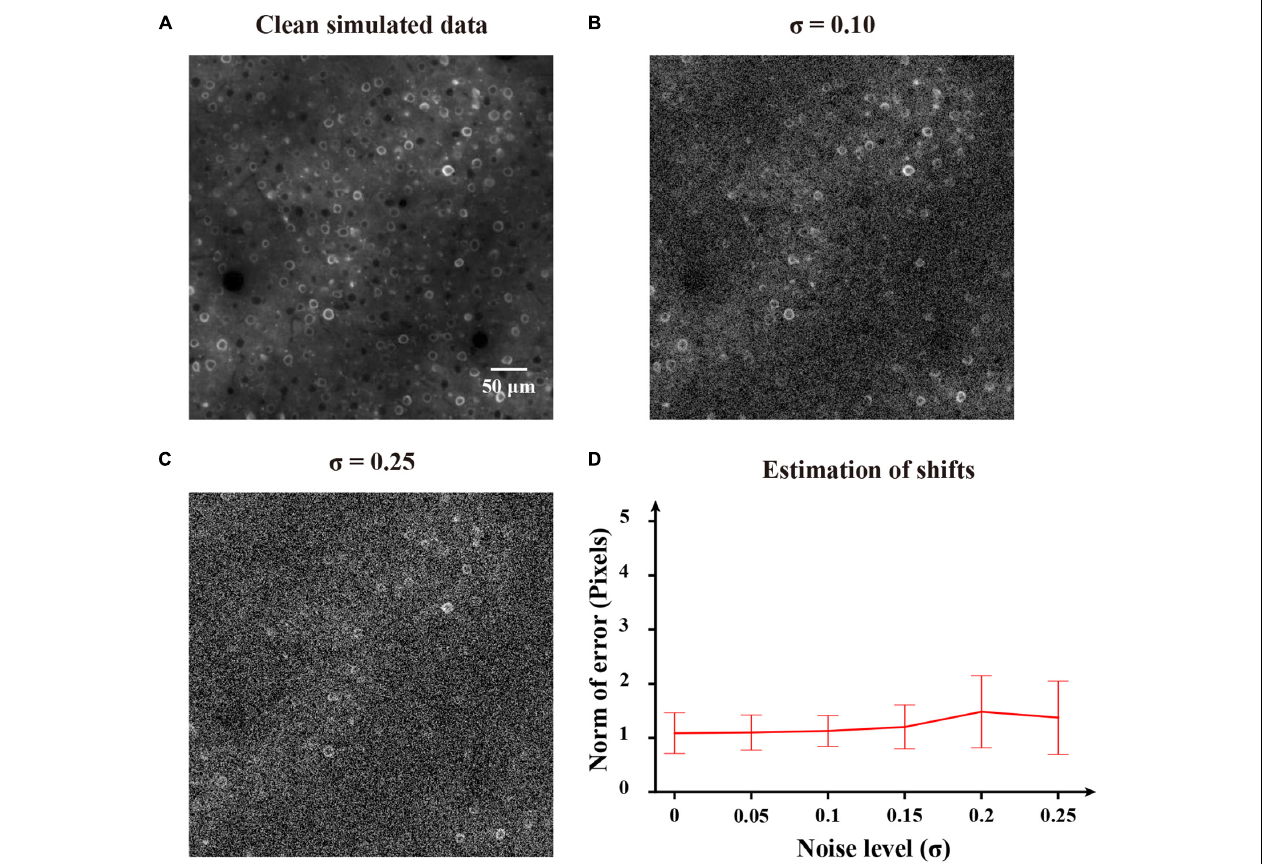
FIGURE 9 | Application of FIFER to simulated data. (A) Template image (the first frame) of the clean simulated data. (B) Template image (the first frame) of the simulated data added with Gaussian noise of a standard deviation σ = 0.10. (C) Template image (the first frame) of the simulated data combined with Gaussian noise of a standard deviation σ = 0.25. (D) Estimation of shifts for the simulated data of different noise levels. FIFER’s error is calculated as the 2d-norm between the estimated offsets by FIFER and ground truth offsets (artificially